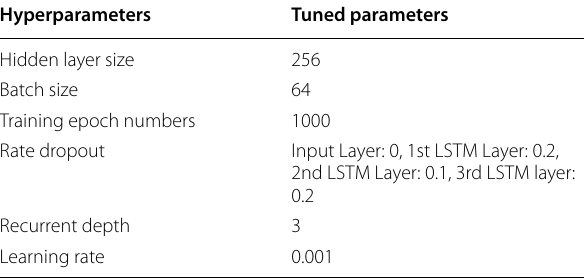
Table 1 Final tuning parameter of LSTM model